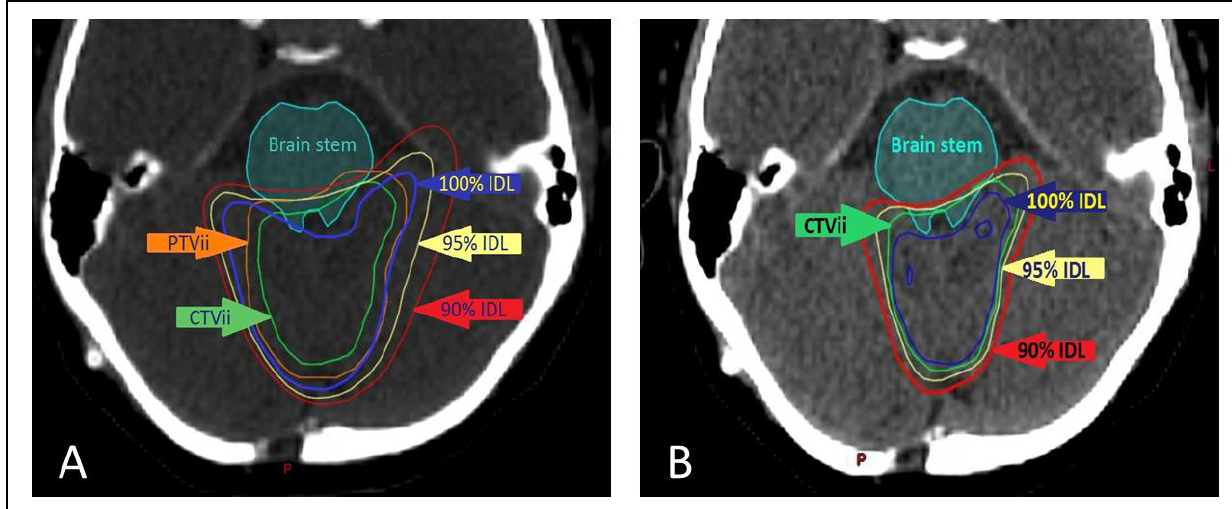
Figure 1: Isodose lines distribution of sum plans (59.4 Gy / 33 fractions) using (A) VMAT (B) Combined VMAT-